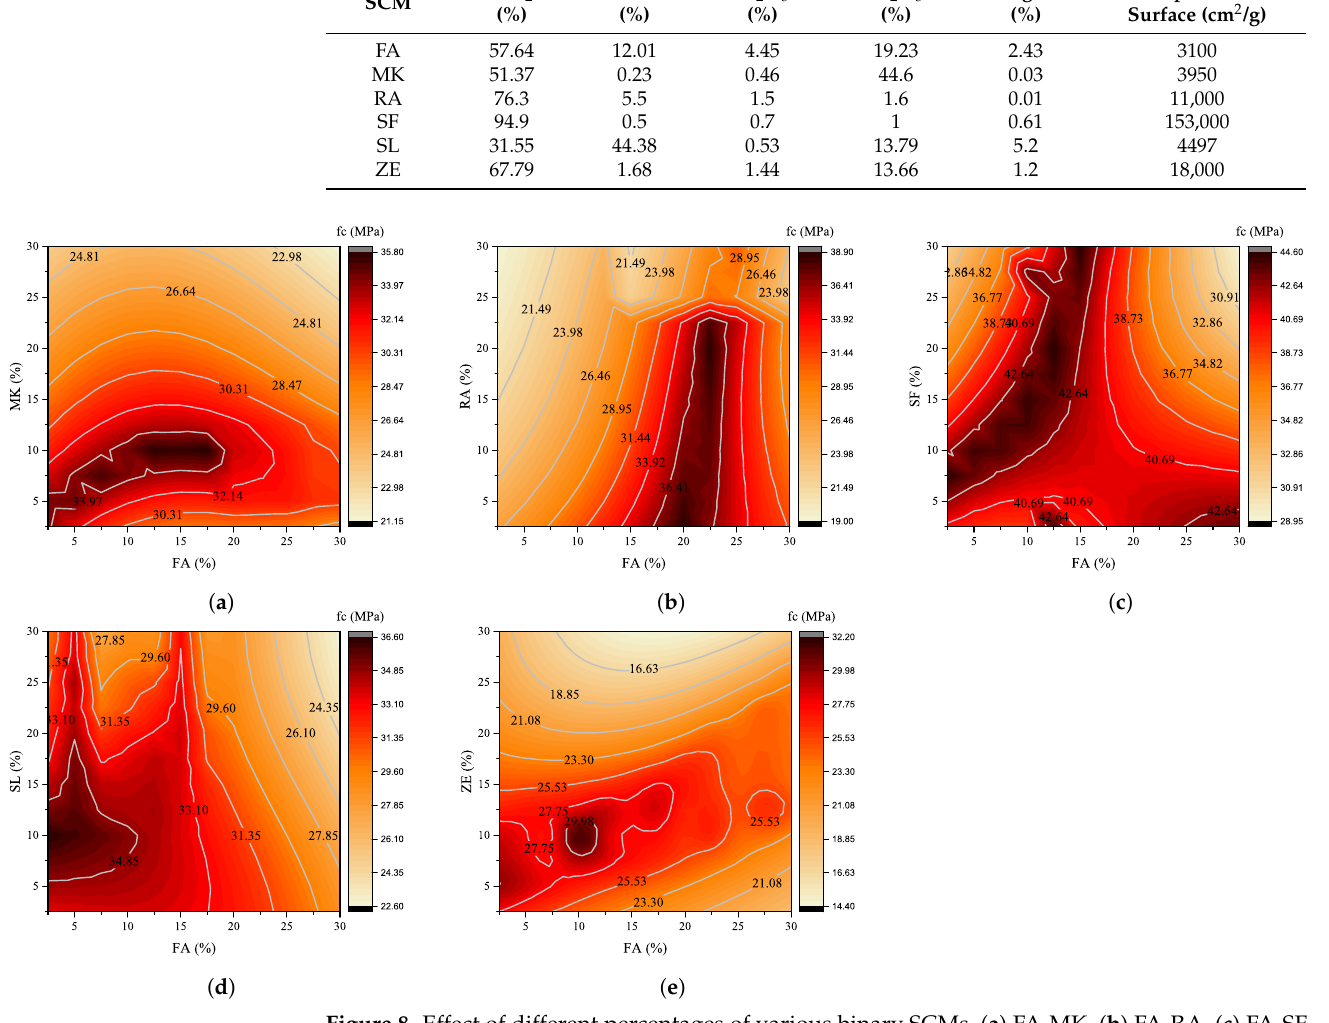
Figure 8. Effect of different percentages of various binary SCMs, ( a ) FA-MK, ( b ) FA-RA, ( c ) FA-SF, ( d ) FA-SL, and ( e ) FA-ZE, on the compressive strength of concrete. As can be seen, the general trend of variation in the compressive strength of concrete containing binary SCMs indicates that there is an optimum level of replacement for each specific combination of pozzolans. For instance, in a concrete mixture with FA and MK replacement, the maximum compressive strength may be obtained for an FA replacement level of less than 20% and an MK replacement level of less than 12%. Moreover, the effect of an increase in the FA replacement is more significant than the MK percentage. Figure 8b shows the changes in the compressive strength of concrete made with a combination of FA and RA. As can be seen, the effect of RA replacement level in improving the compressive strength is less than FA. The main reason for this trend may be attributed to the